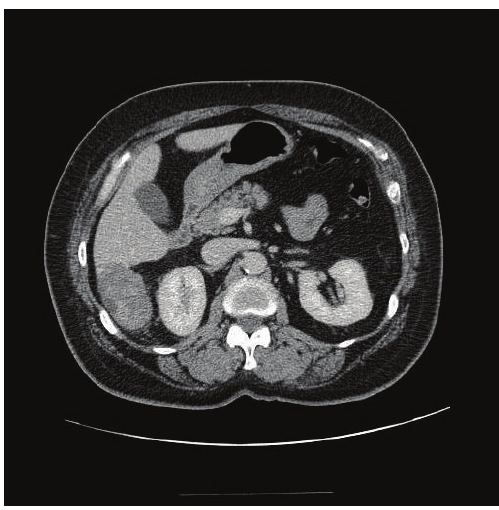
Figure 1: Unenhanced computed tomography of the liver demon- strates a 53.5 mm heterogeneous area in segment six (arrow).